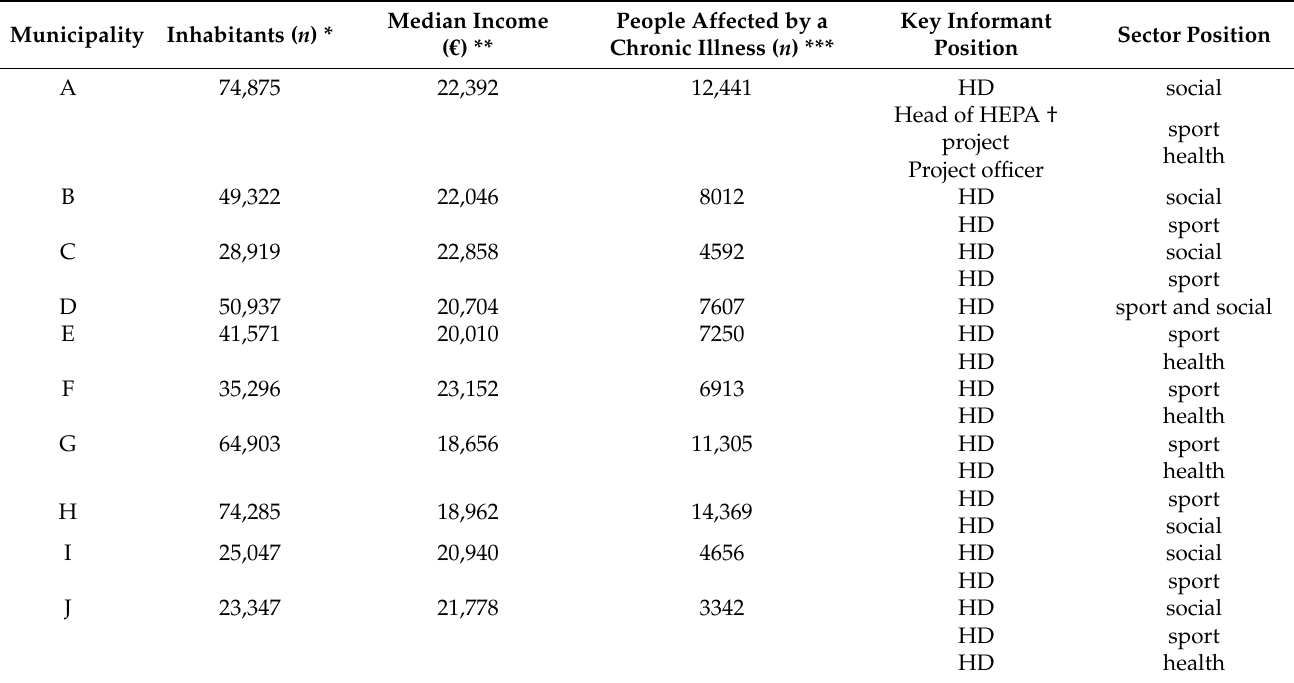
Table 1. Characteristics of the municipalities and key